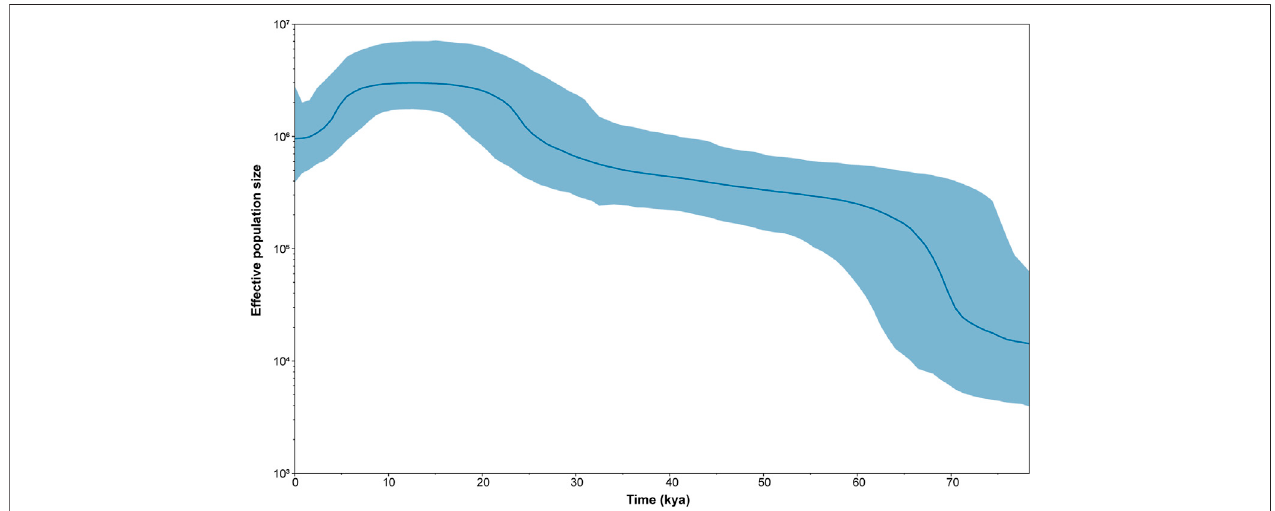
FIGURE3| TheBayesianskylineplot(BSP)ofchangesineffectivepopulationsizethroughtimefortheDaurethnicgroup.Thedarkbluelinerepresentsthemedian population, and the blue line demarcates the boundaries of the 95% highest posterior density.